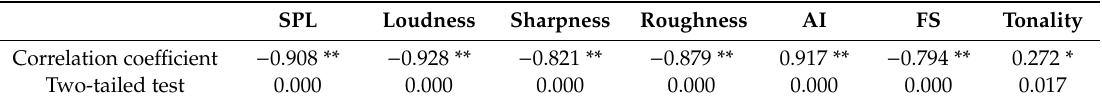
Table 3. Correlation coefficients between the sound quality (SQ) scores and the physical- psychoacoustical parameters. SPL, sound pressure level; AI, articulation index; FS, fluctuation strength. SPL